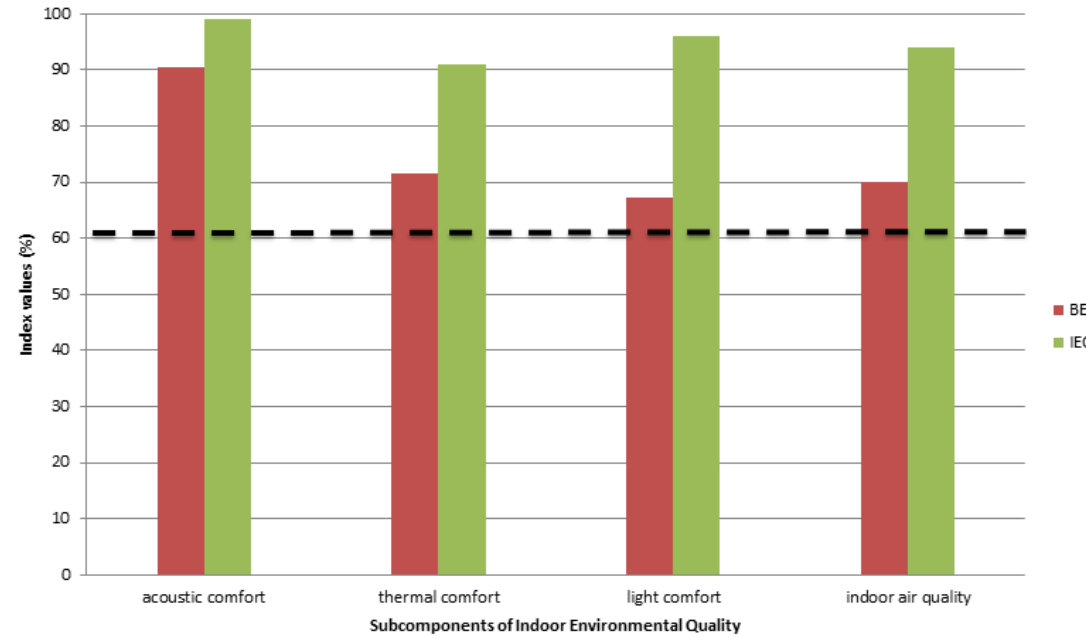
Figure 8. Summary of the assessment results of the subcomponents of the indoor environment of the case-study building on a percentage scale using IEQ and building environmental effectiveness (BEE) methods (the dotted line indicates the minimum accepted level of requirements resulting from national regulations according to the BEE method, 100% is best performance).